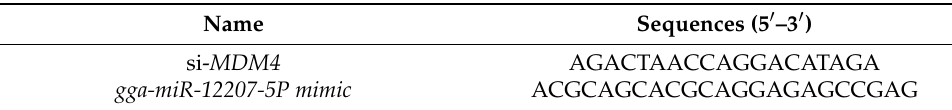
Table 2. Oligonucleotide sequences in this